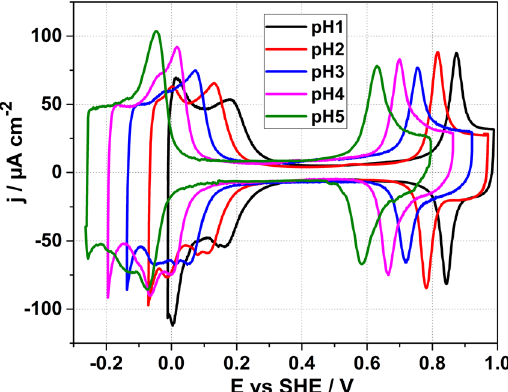
Figure 1. Voltammogramms of Ir(111) electrodes recorded at 50 mV/s in Ar-saturated solutions of: 0.1 M HClO 4 (pH = 1), 0.01 M HClO 4 + 0.099 M KClO 4 (pH = 2), 1 mM HClO 4 + 0.1 M KClO 4 (pH = 3), 0.08 M